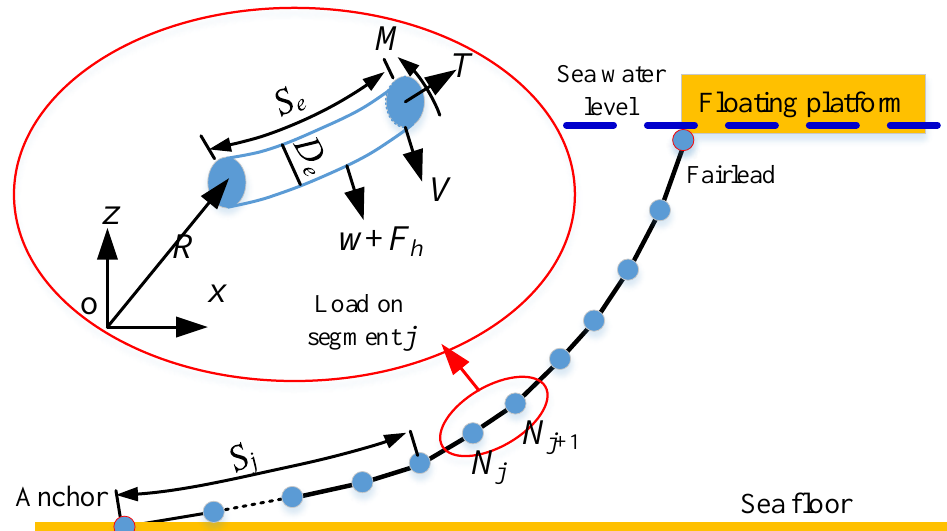
Figure 7. Schematic diagram of the dynamic model of mooring lines.